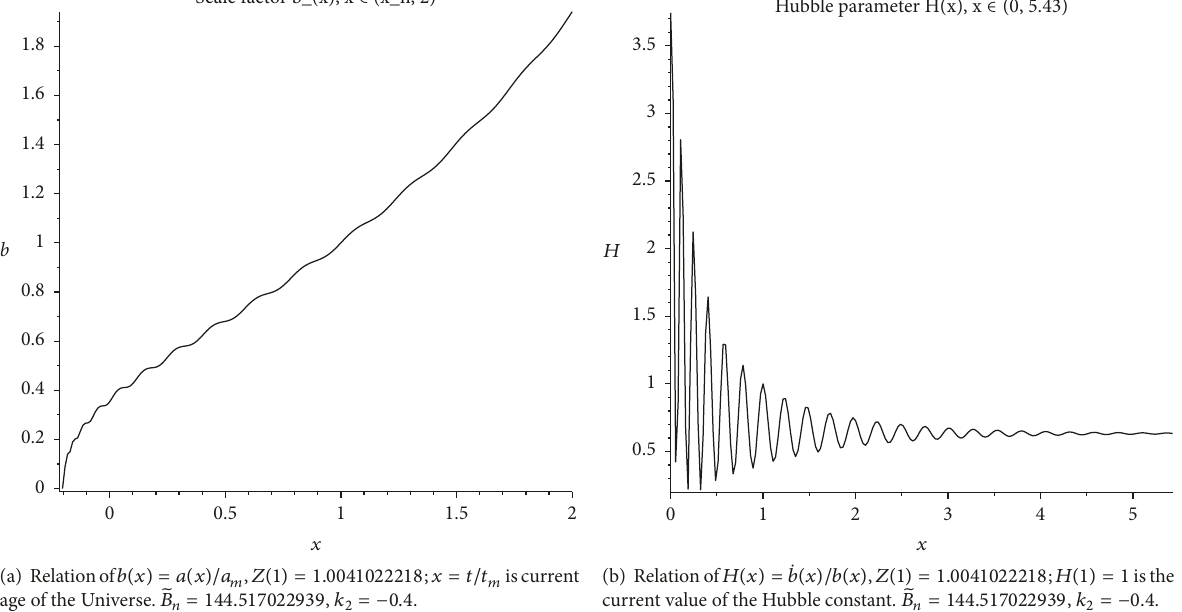
(a) Relationof 𝑏(𝑥) = 𝑎(𝑥)/𝑎 𝑚 , 𝑍(1) = 1.0041022218 ; 𝑥 = 𝑡/𝑡 𝑚 iscurrent age of the Universe. ̃𝐵 𝑛 = 144.517022939 , 𝑘 2 = −0.4 .